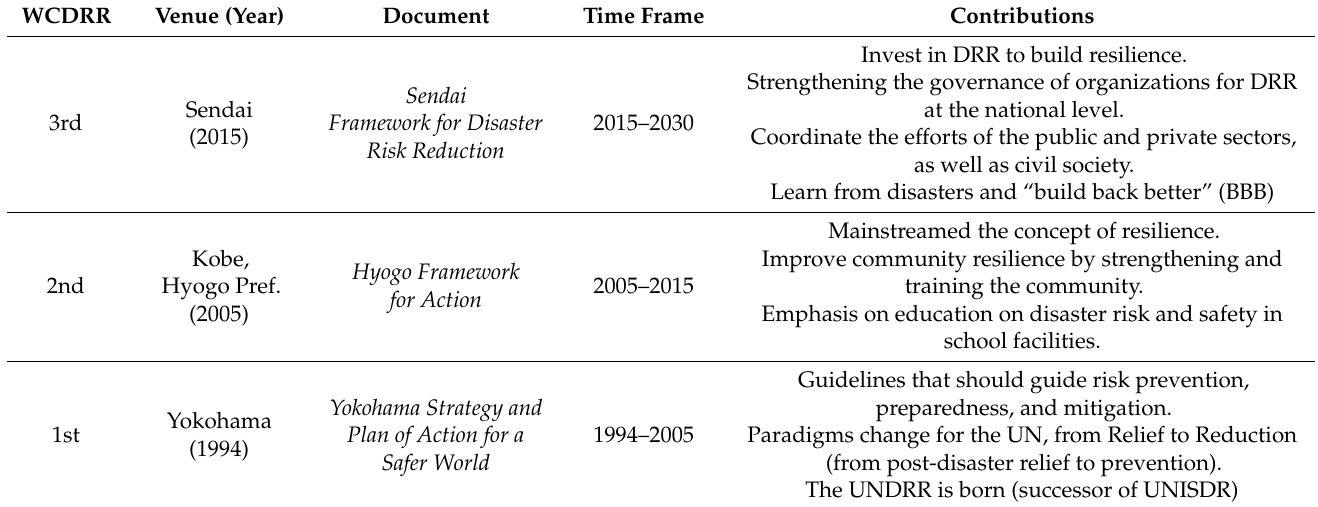
Table 2. Summary of the contributions of the UN World Conferences on Disaster Risk Reduction